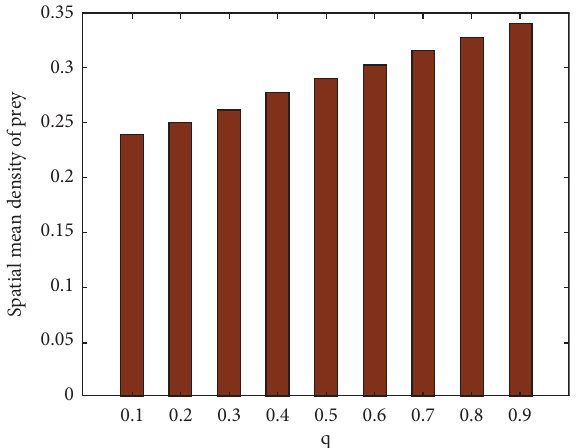
Figure 9: Mean density of the prey with respect to interval variable q